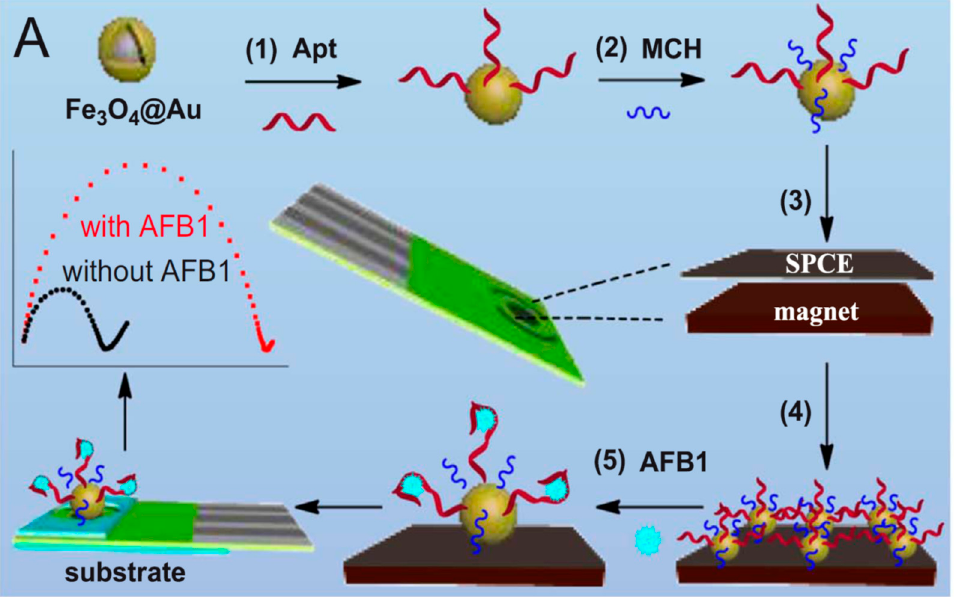
Figure 6. Schematic illustration of the fabrication of a magnetically assembled aptasensor for AFB1. Reprinted from [79], with permission.